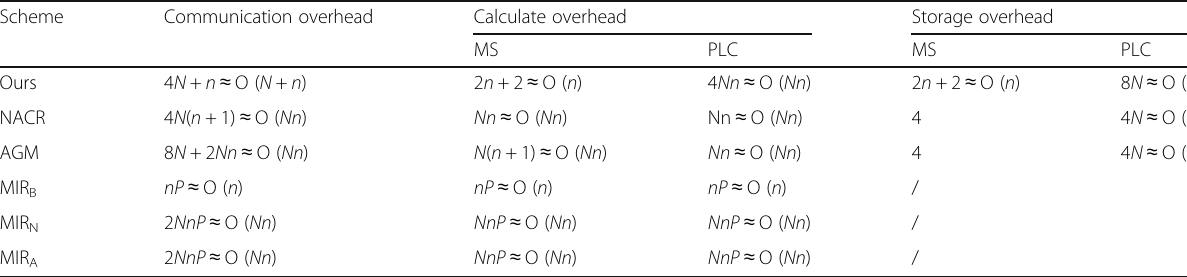
Table 1 Performance analysis and comparison